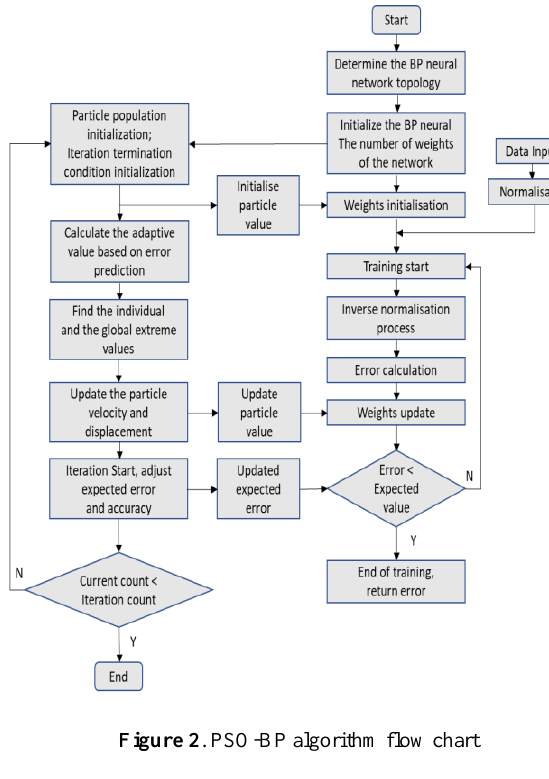
Figure 2 . PSO-BP algorithm flow chart